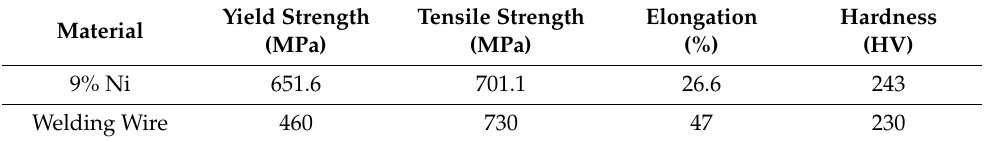
Table 2. Mechanical properties of 9% Ni steel.